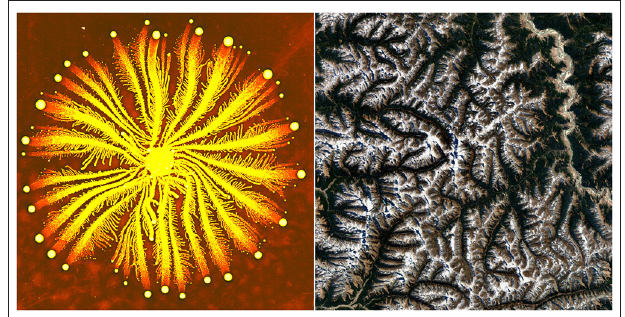
FIGURE 2 | Illustration of morphological similarity between a microbial culture and natural landscape. A colony of Paenibacillus vortex bacteria (image by Prof. Eshel Ben-Jacob, CC BY-SA 3.0) (Left) . Mountainous landscape in Mainling, Nyingchi, Tibet, as seen on Google Earth (Right)